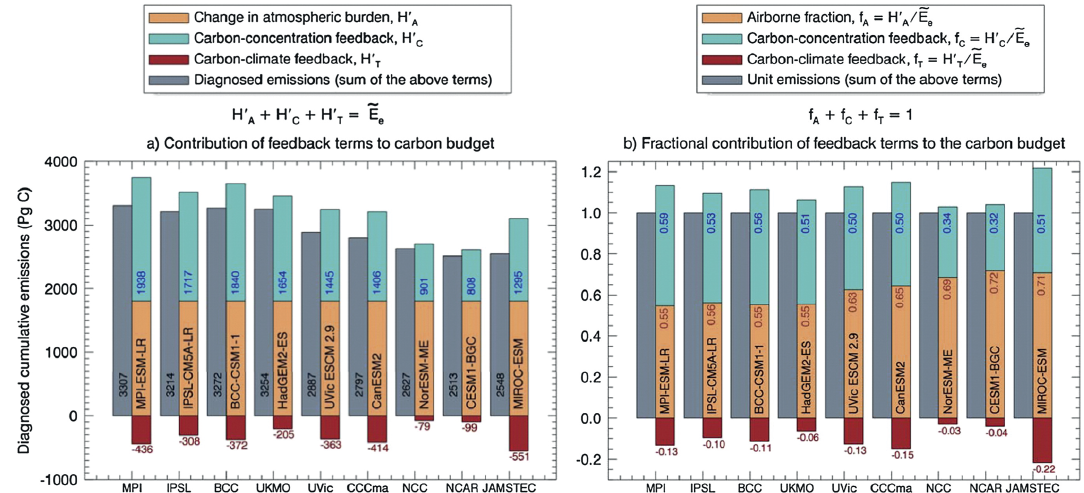
Figure 18. Contributions of the carbon-concentration feedback and the simplified carbon cycle–climate feedback to “compatible CO 2 emissions” to the atmosphere. Large diagnosed emissions correspond to more negative feedback than low diagnosed emissions. (a) Absolute contributions in PgCyr − 1 and (b) fractions of compatible cumulative emissions. The atmosphere contribution in panel (a) is constant because the atmospheric CO 2 concentrations were prescribed in this experimental set-up. For details, see the original source: Figure 7 in Arora et al. (2013). © American Meteorological Society. Used with